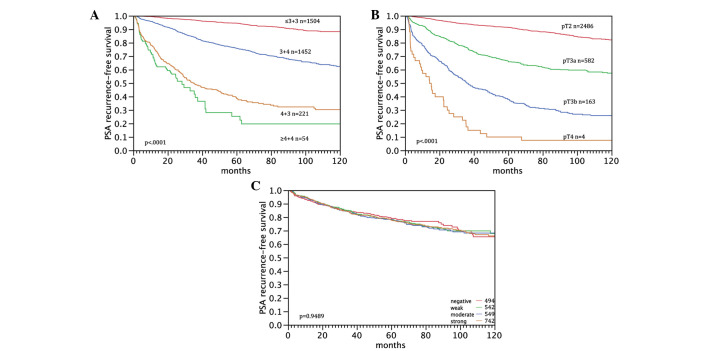
Influence of clinicopathological features and c-MET staining on PSA recurrence. (A) Gleason grade. (B) pT category. (C) c-MET immunostaining. PSA, prostate-specific antigen.